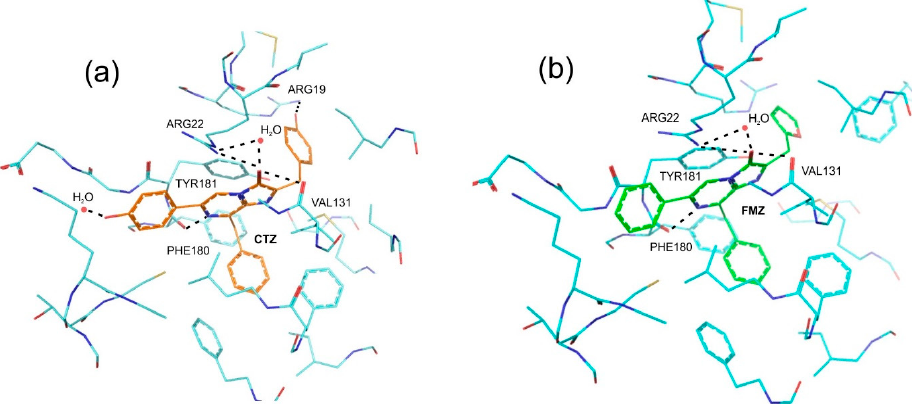
Figure 2. Protein active sites (PDB code 2HPS) with coelenterazine ( a ) and with furimazine ( b ). Water molecules are shown as red balls. Inferred hydrogen bonds are shown as dotted lines. The specified amino acids are involved in the formation of hydrogen bonds.